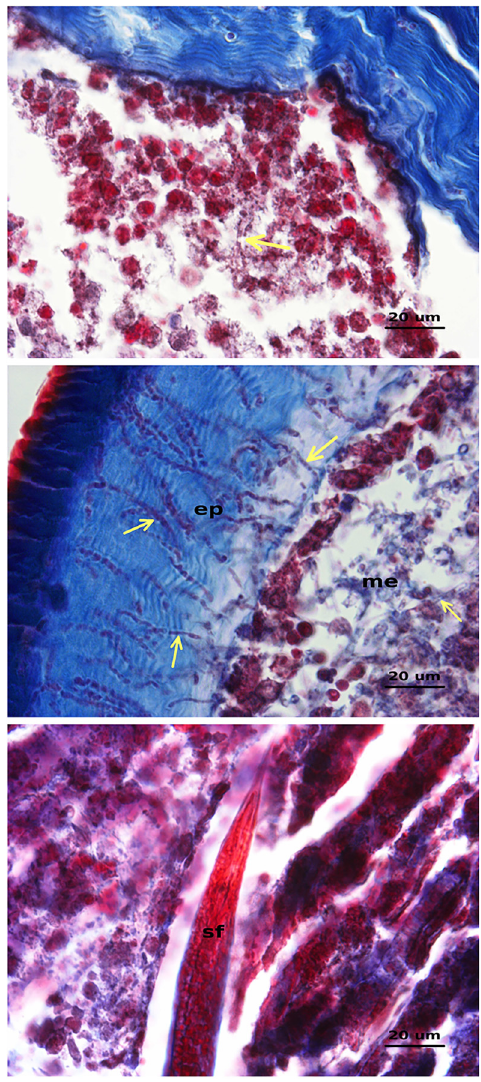
Fig 7. Longitudinal sections of L . decemlineata last-instar larvae infected with both I . fumosorosea and S . feltia e simultaneously. (A) Insect tissues with a few hyphal bodies of I . fumosorosea (yellow arrows) 48 hours after the treatment. (B) Hyphal bodies of I . fumosorosea (yellow arrows) penetrating epidermis (ep) and mesoderm tissues (me) 72 hours after the treatment. (C) Front part of a fertile adult female of S . feltiae (sf) full of eggs inside of tissue thoroughly invaded by hyphae of I . fumosorosea 72 hours after the